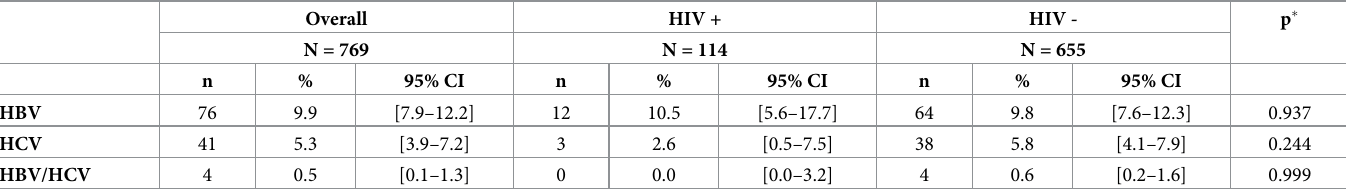
Table 3. Prevalence of hepatitis B and hepatitis C among female sex workers in Togo in 2017 (N = 769).